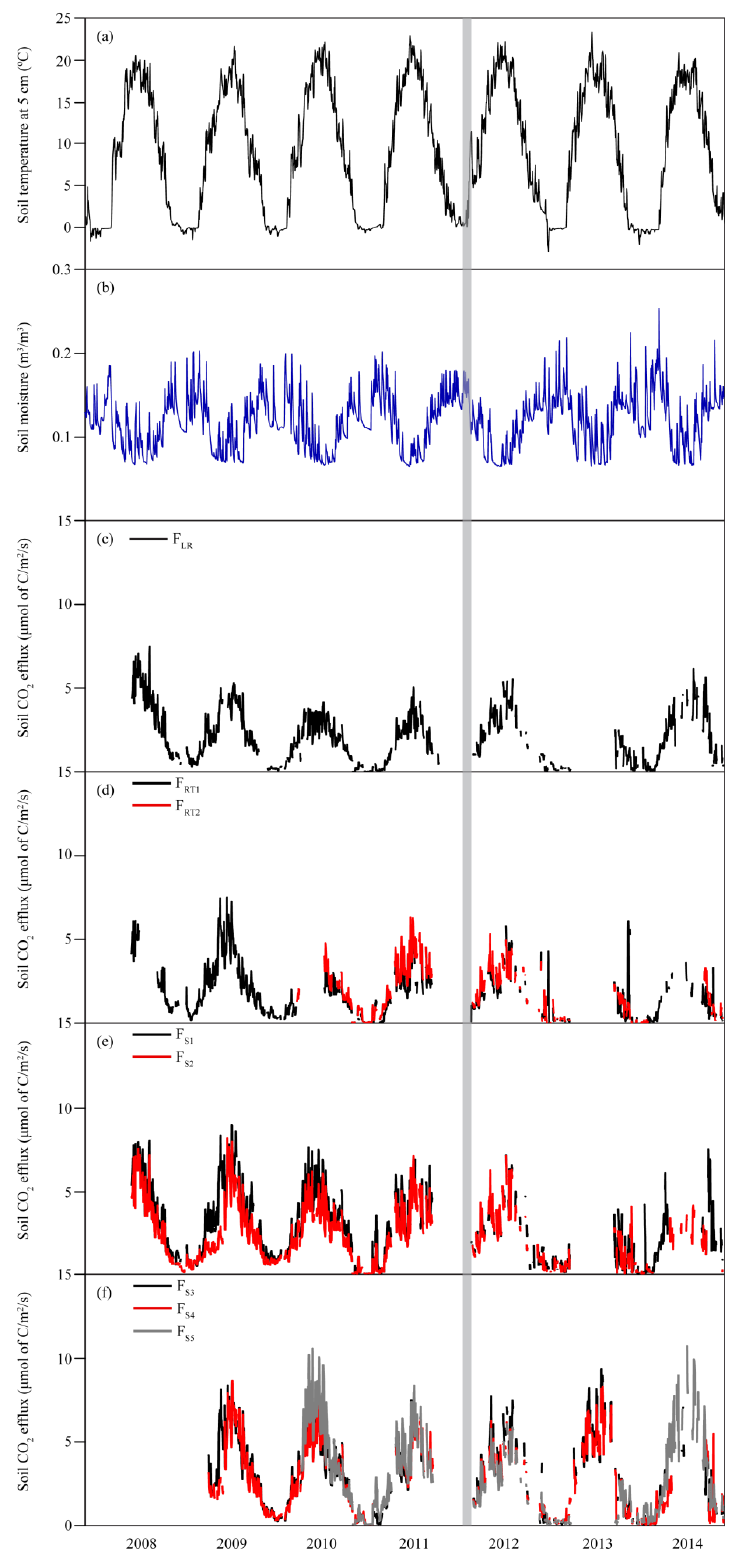
Figure 1. Daily values of ( a ) soil temperature at 5 cm depth; ( b ) soil moisture averaged between 0 and 30 cm depths; and soil CO 2 efflux from ( c ) mineral-soil efflux (F LR ), ( d ) root trenched efflux (F RT1 and F RT2 ), ( e ) initial group of control (F S1 and F S2 ) chambers, and ( f ) latest group of control (F S3 , F S4 , and F S5 ) chambers, from 2008 to 2014. Grey line denotes timing of the shelterwood harvesting